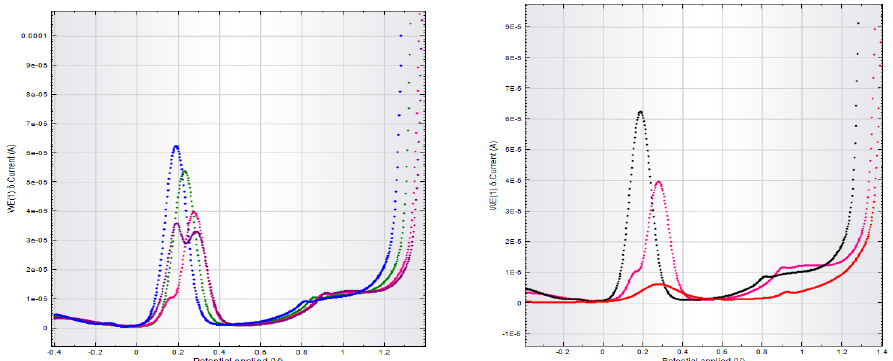
Figure A10. Left : DPV registered on graphite-based SPE in the presence of 2 mM TEMPO (blue) and for 2 mM TEMPO after one hour incubation with different concentrations of ascorbic acid: 0.25 mM (green); 0.5 mM (pink ) 1mM (purple). Right : DPVs registered on graphite-based SPE in the presence of 2 mM TEMPO (black); 0.5 mM ascorbic acid (red) and for 2 mM TEMPO after one hour incubation with 0.5 mM (pink) of ascorbic acid. Solutions are prepared in 0.1 M HClO 4 . Similar effect was followed in the case of the studied compounds (Figure A11).